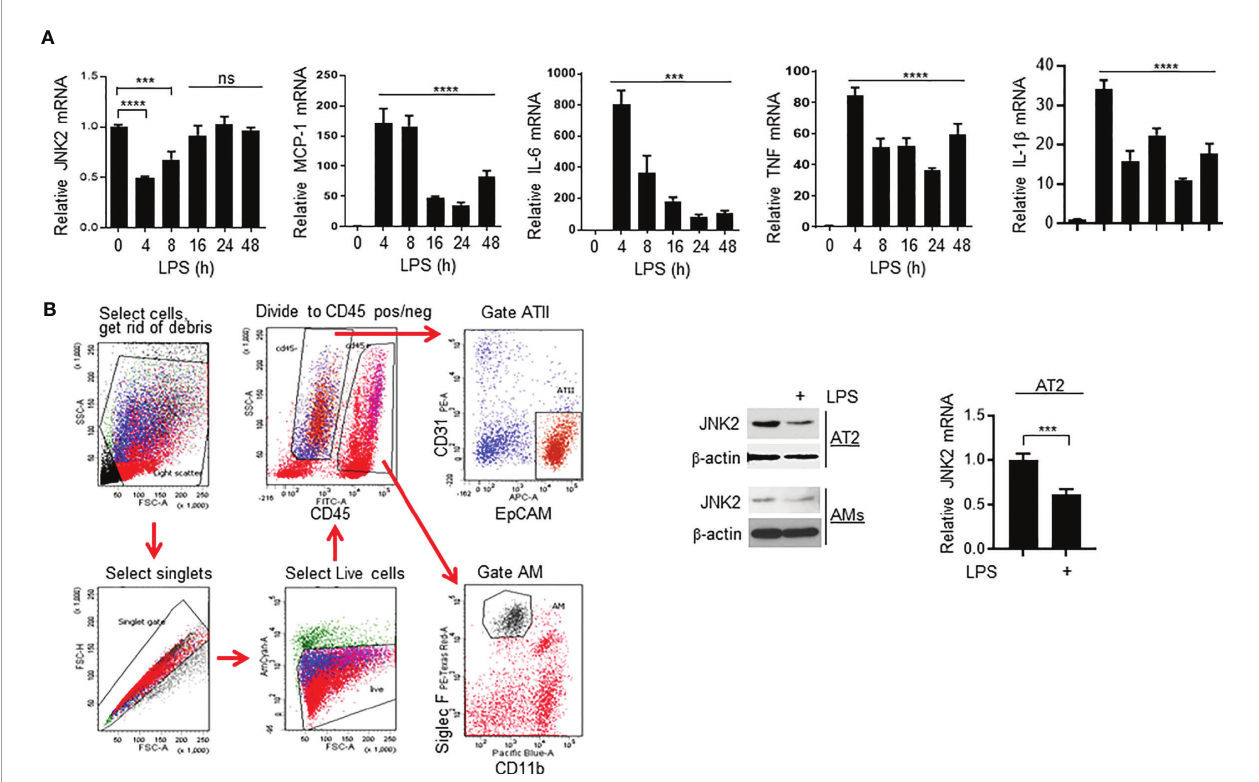
FIGURE 6 | JNK2 mRNA levels are also negatively correlated with lung injury severity in LPS-induced ALI model. (A) mRNA expressions of JNK2 or in fl ammatory cytokines in whole lung homogenates of wild-type mice treated with i.t. LPS. (B) Left panel, gating strategy to fl ow sort AT2 cells and AMs from PBS-treated mouse lung. Middle panel, JNK2 protein expression in AT2 cells and AMs fl ow-sorted from PBS- or LPS-treated whole lung homogenates. Right panel, JNK2 mRNA level in AT2 cells fl ow-sorted from PBS- or LPS-treated mouse lung. N=3-6. Data are presented as means ± sem. *** p < 0.001; **** p < 0.0001; ns, not signi fi